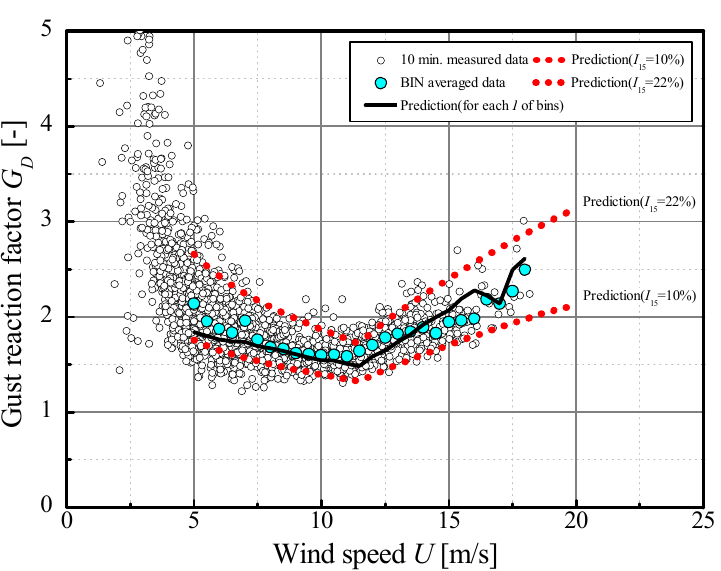
Fig. 7 Comparison of gust reaction factor derived from suggested equation and measured